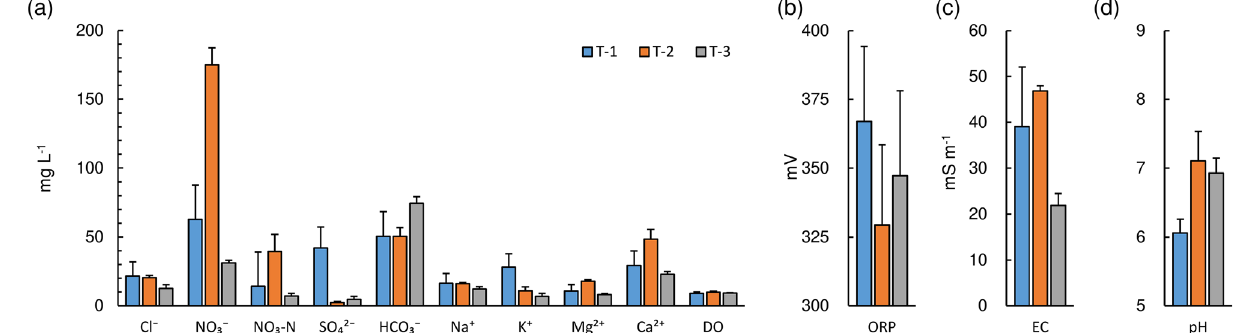
Figure 3. Chemistry of groundwater ( a ) Major ion components and DO, ( b ) ORP, ( c ) EC, and ( d )